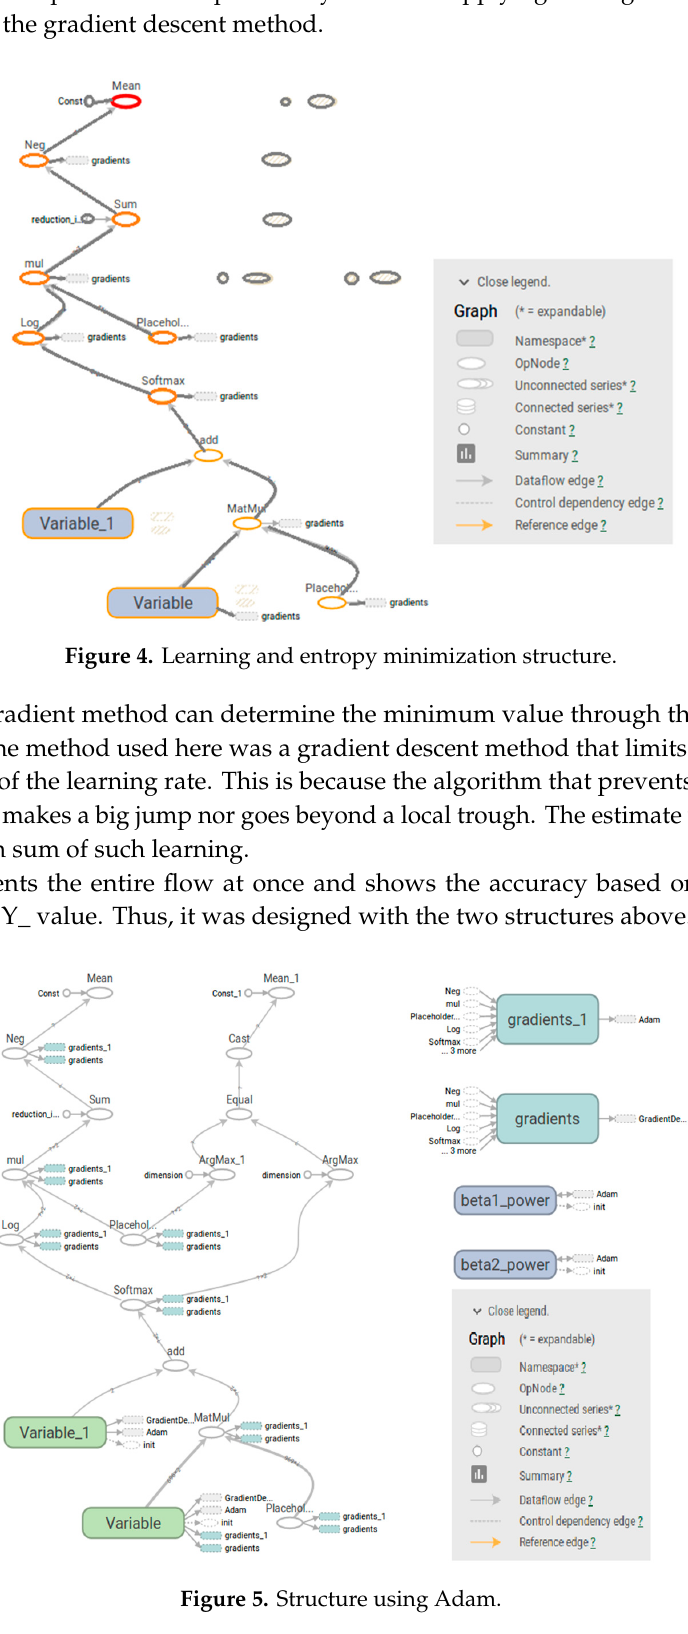
Figure 3. Comparison structure for the validation data application and Y value.